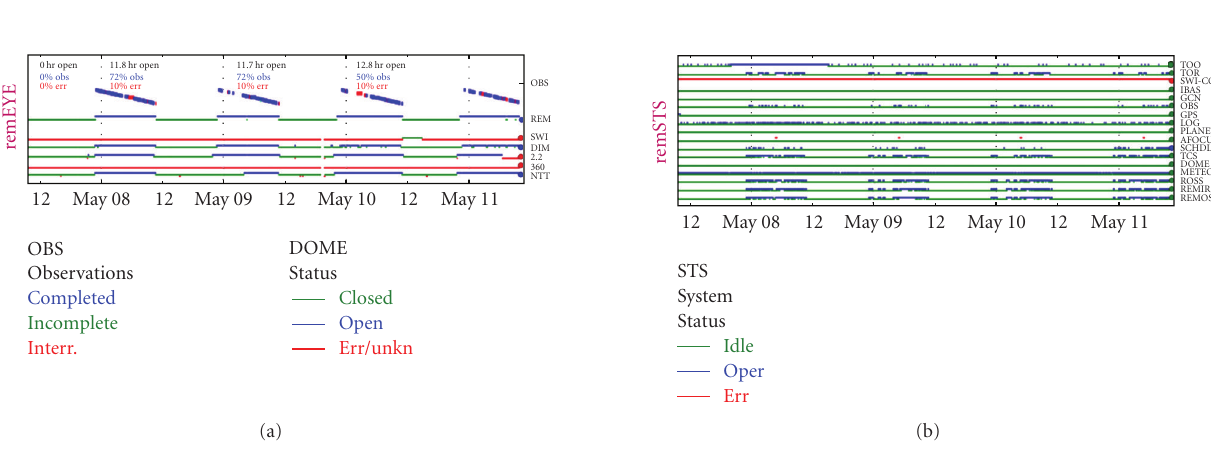
Figure 4: tREMometer first glance at http://www.ls.eso.org/lasilla/rem/ o ff ers the alarm status (on the left, here all is green and working) and the working night sky over La Silla. All remaining targets for the night, listed on the right, are positioned in the sky hemisphere as blue, numbered dots. Other important information includes the actual telescope pointing, the Swift (green), INTEGRAL (yellow), and AGILE (cyan) current pointing. Also the position of the last alerted GRB (orange) is shown.